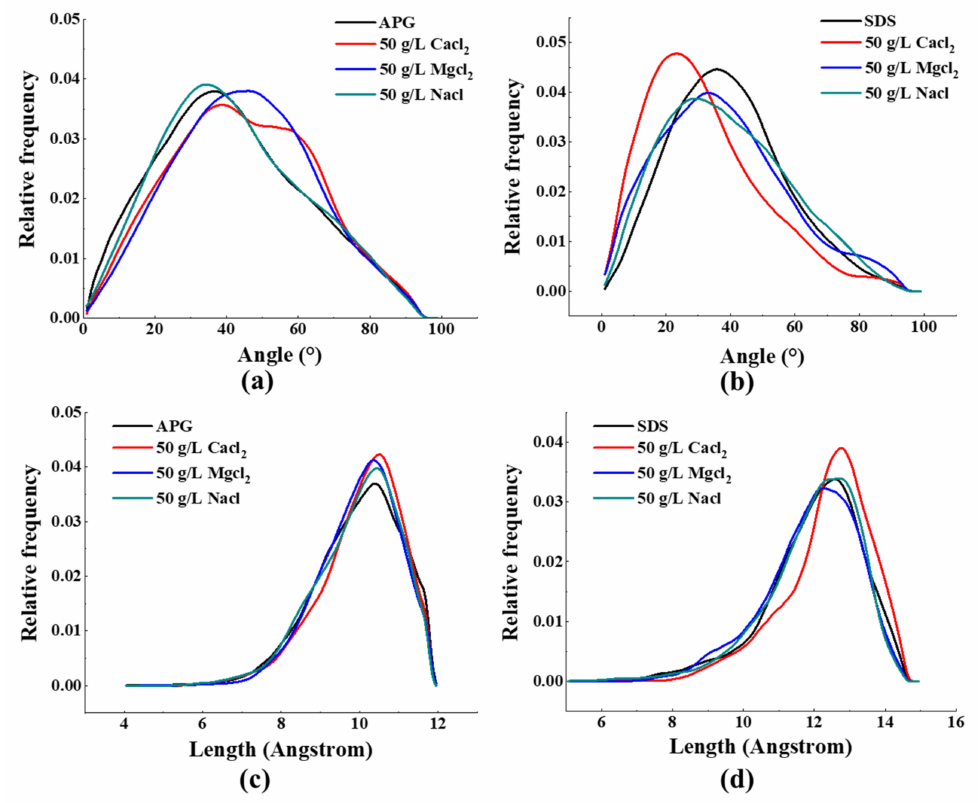
Figure 18. Arrangement and orientation of tail groups in different foam. ( a ) APG foam ( θ tail ), ( b ) SDS foam ( θ tail ), ( c ) APG foam (L tail ), and ( d ) SDS foam (L tail